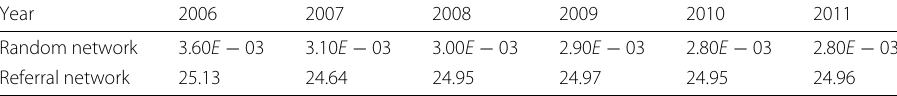
Table 7 Comparison of average common connected nodes between neighbors on a referral path and the expectation in a random network with the same